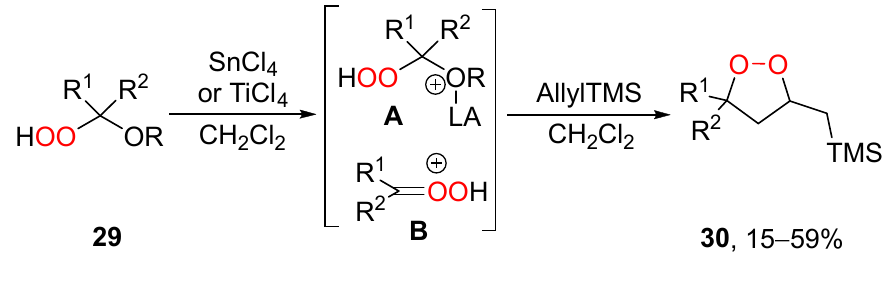
Scheme 9. Intramolecular cyclization of peroxyacetals 23 , 25 , and 27